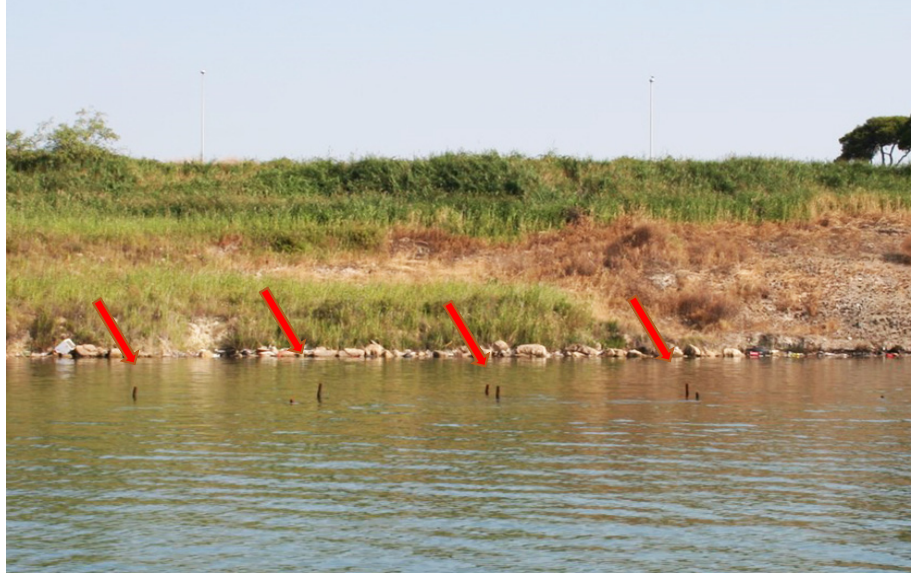
Figure 4. Ancient mussel farms abandoned and never restored (the red arrows indicate the barely visible poles on the water). First inlet of Mar Piccolo (Puglia Region). May 2018.